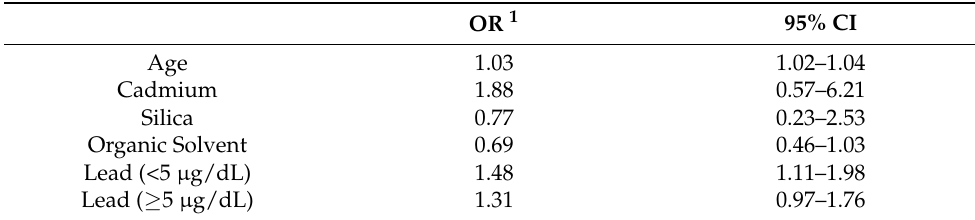
Table 3. The Adjusted Odds of EM by BLLs (<5 µ g/dL, ≥ 5 µ g/dL) and Cadmium, Silica, and Organic